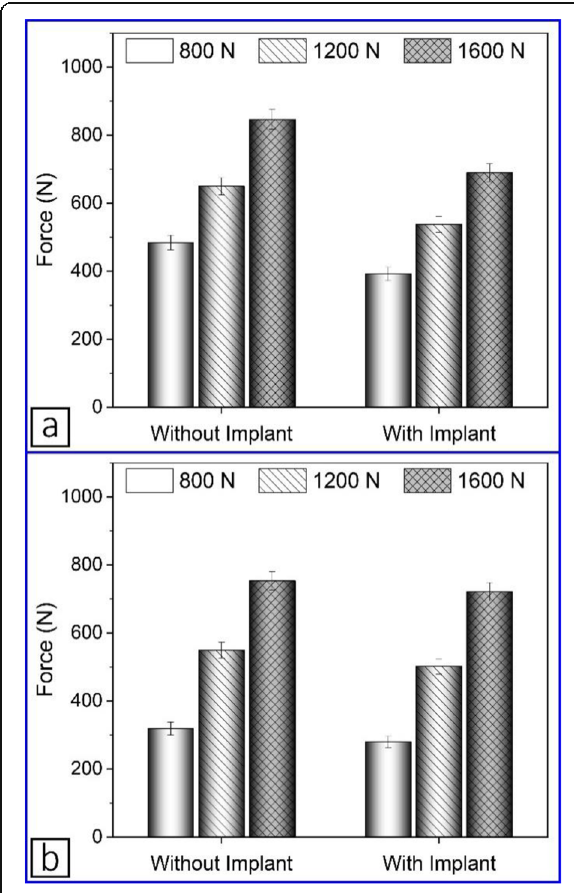
Fig. 13 Force in the knee compartment without and with implant: a medial, b lateral